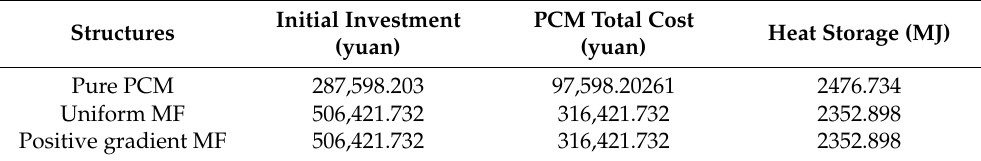
Table 5. Cost and heat storage of three structures.